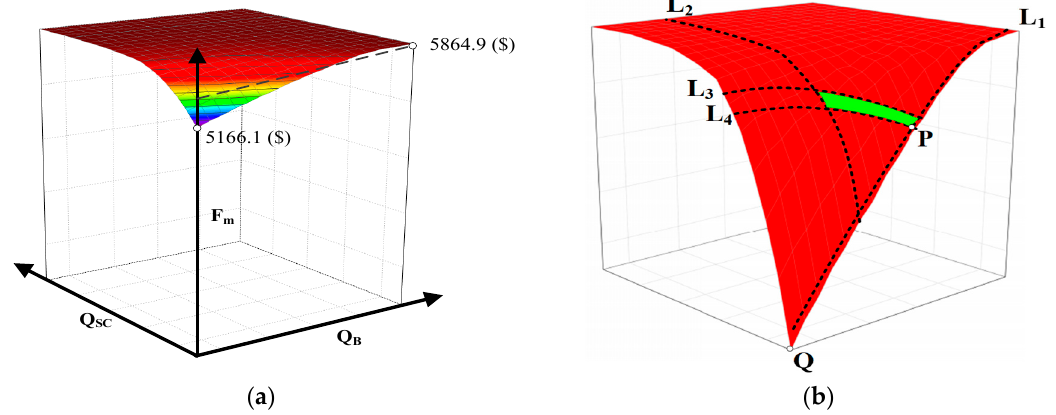
Figure 5. The relationship among the battery installation capacity, the super-capacitor installation capacity, and the average daily generation cost of the distributed power system: ( a ) an overview; ( b ) in a detailed version.